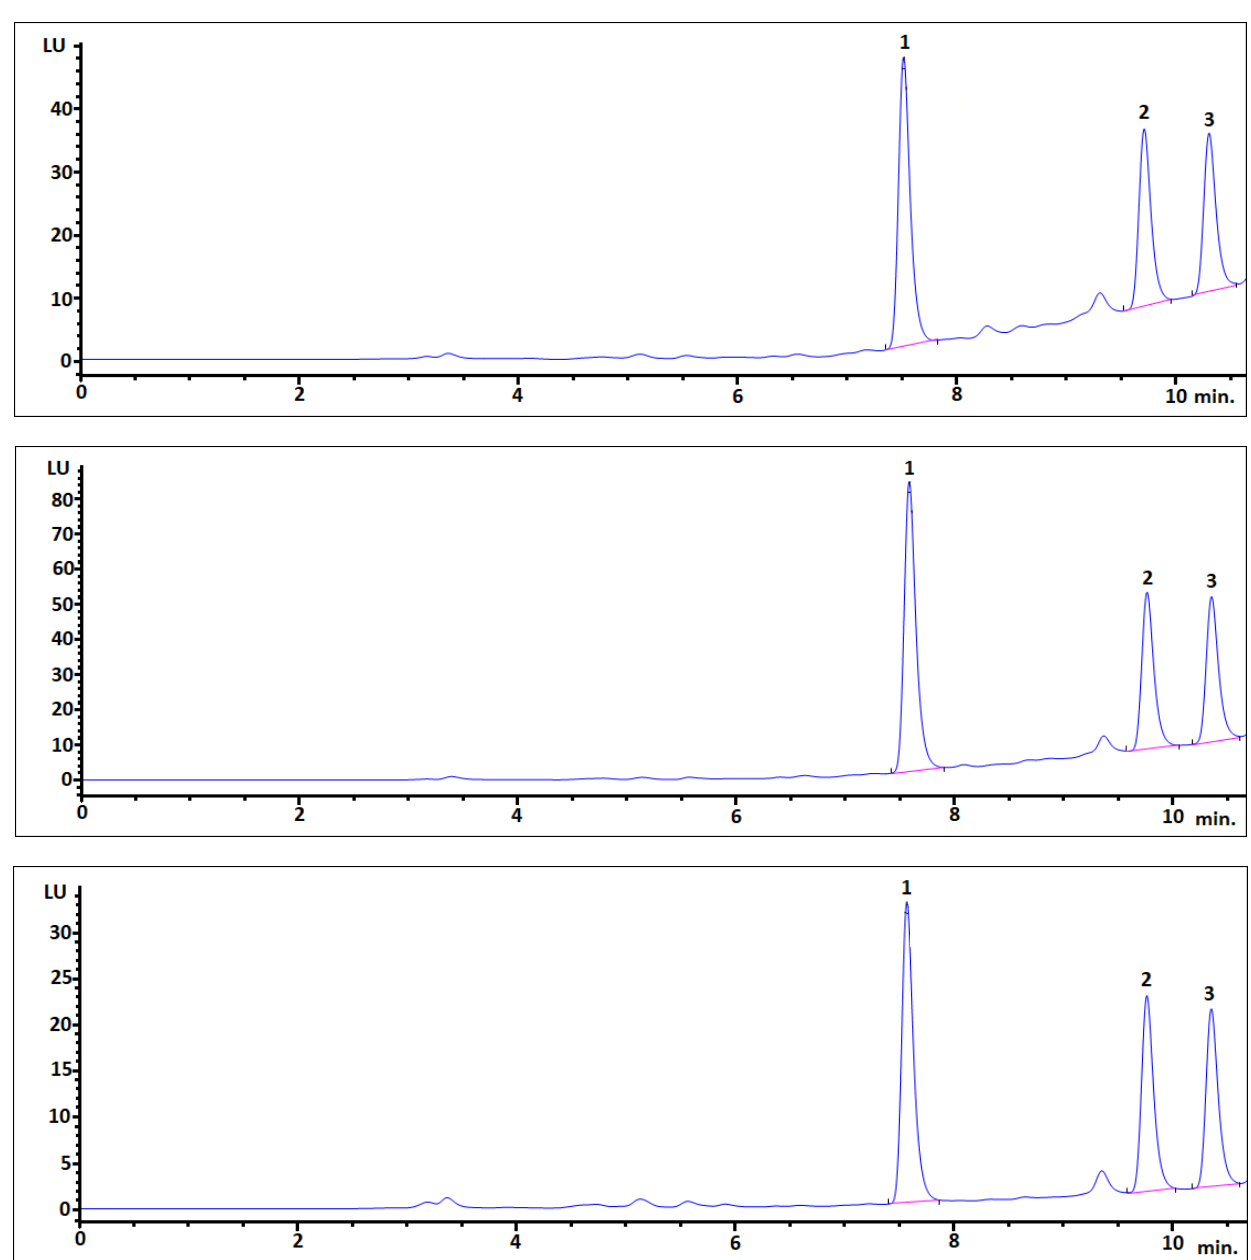
Figure 1. Comparison of the enrichment levels of urine human samples at three following levels (from top to below): 1 × LOQ (a reinforcement—10), 1.5 × LOQ, and 3 × LOQ (a reinforcement—12 for top and middle, a reinforcement—10 for bottom).